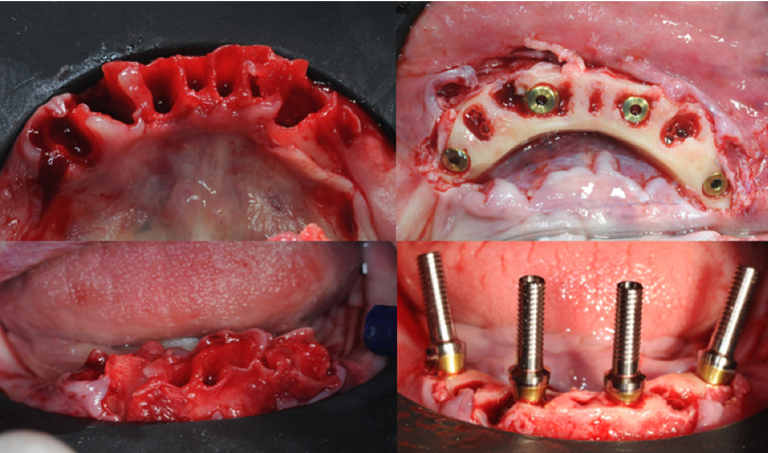
Figure 14. Comparison of patient’s oral cavity pre- and post-osteotomy.